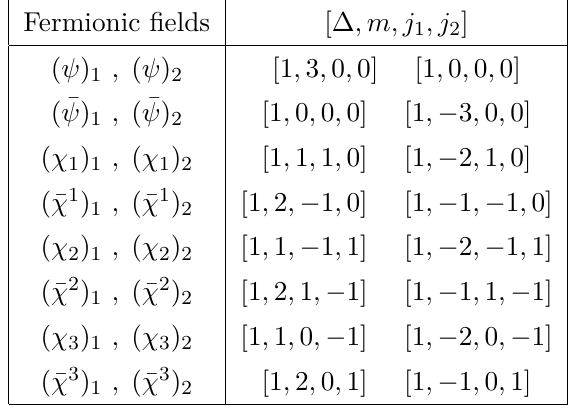
Table 4. Quantum number assignments to fermionic matter fields of the ABJ(M) theory defined in eq.